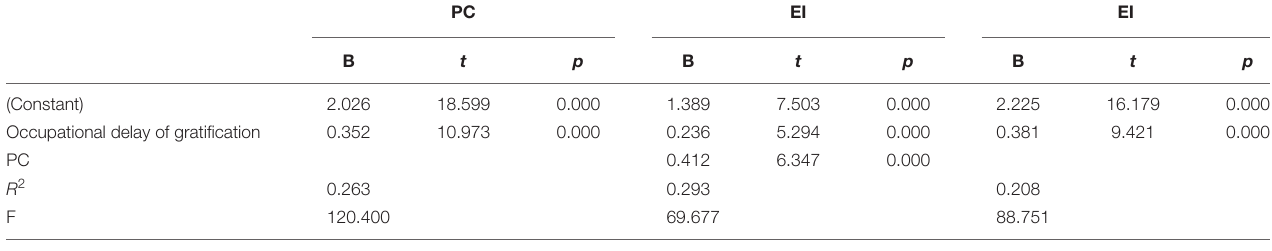
TABLE 12 | Mediating effect test.